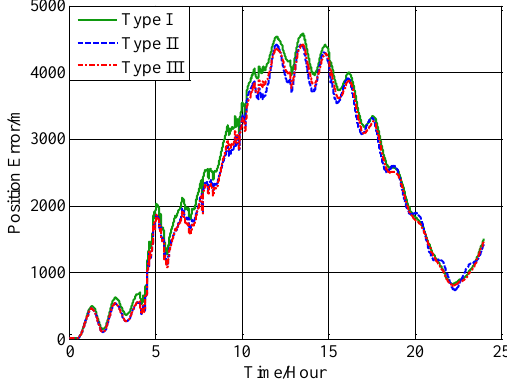
Figure 18. The comparison of the position error.